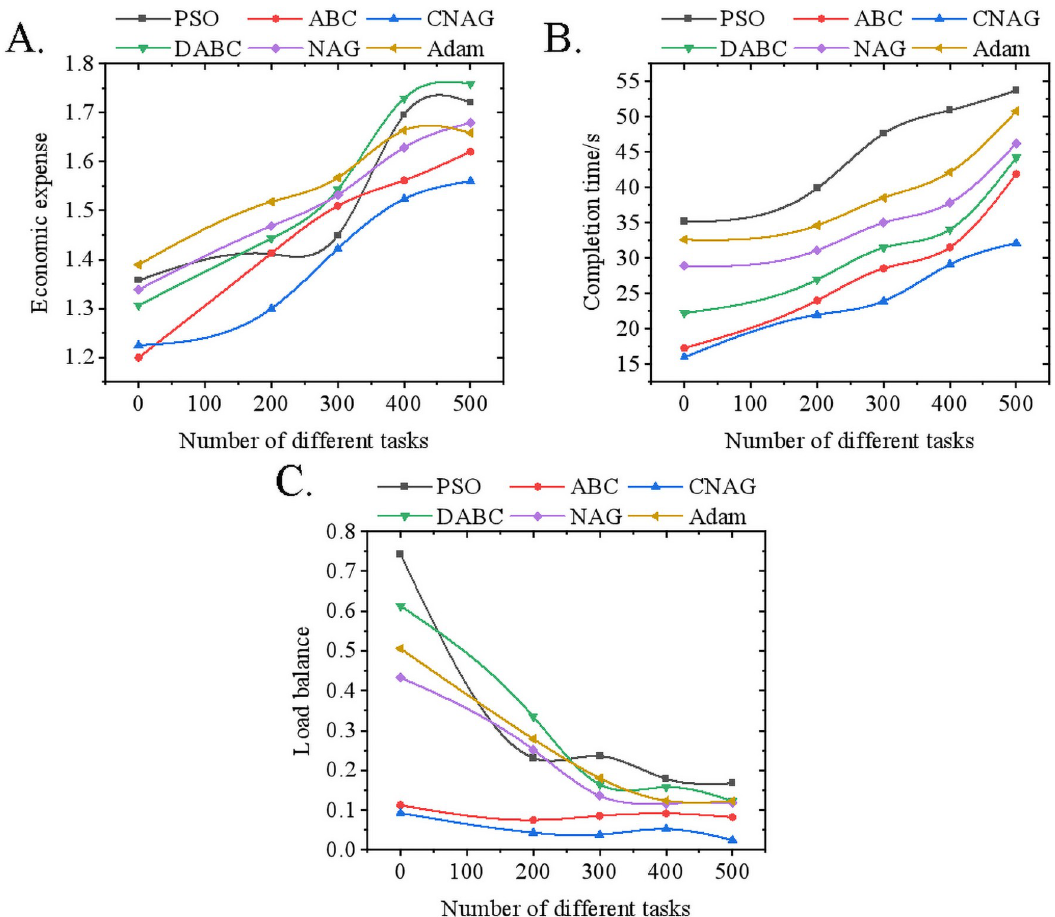
Fig 9. Comparison of stimulation results of different models. Note: Fig A-C represent the comparison of different models in economic cost, load balancing and completion time.